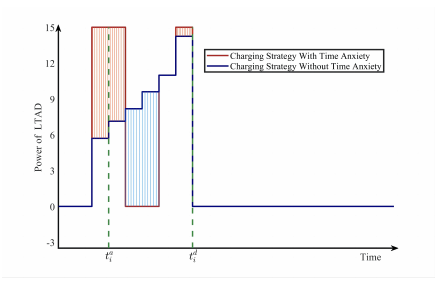
Figure 10. The time anxiety impact of LTAD.